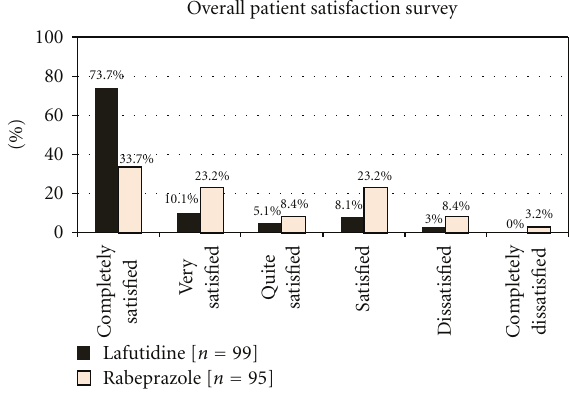
Figure 4: Frequency distribution of satisfaction survey responses at the end of the treatment